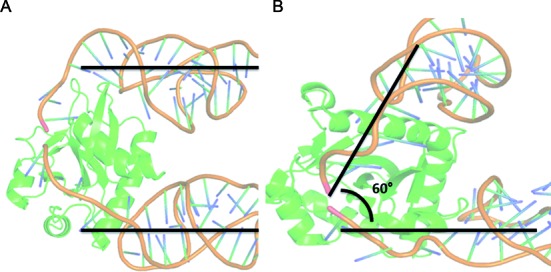
The heterotetrameric quaternary structure and the geometry of the bound RNA. (A) It can be seen that the incoming and outgoing RNA strands in CptINEr are completely parallel, driven by a much more extensive single stranded region at both the 5′ and 3′ ends of CptIEr looping into the protein. (B) In ToxINPa, the interfaces are much more direct in relation to the ToxIPa duplex, creating a 60° angle between adjacent ToxIPa strands, leading to the formation of a heterohexamer.